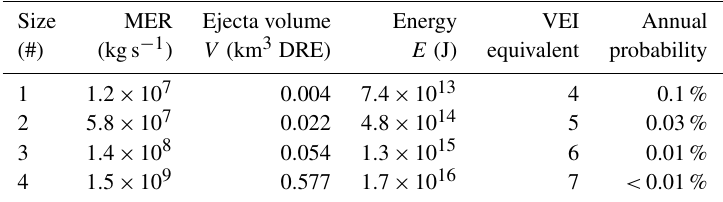
Table 1. Eruption sizes used in the Taup¯o model, where MER is chosen from Barker et al. (2019). Annual probabilities from Stirling and Wilson